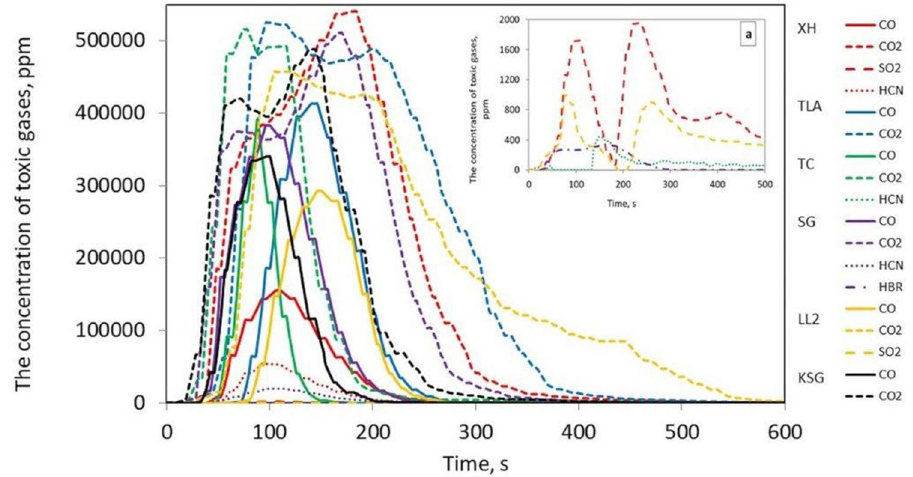
Figure 3. Toxic gas concentrations during the thermal decomposition and combustion of the flat drive belts; detail a shows a smaller measuring range from 0 to 2000 ppm.